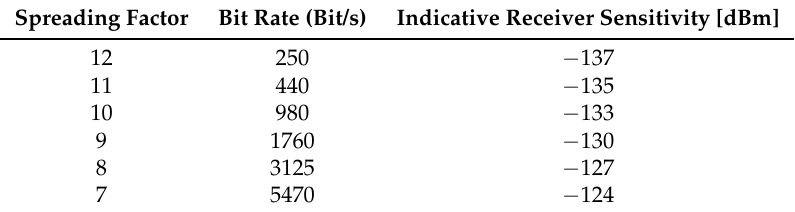
Table 2. Bit Rates and Receiver Sensitivities for the 125 kHz